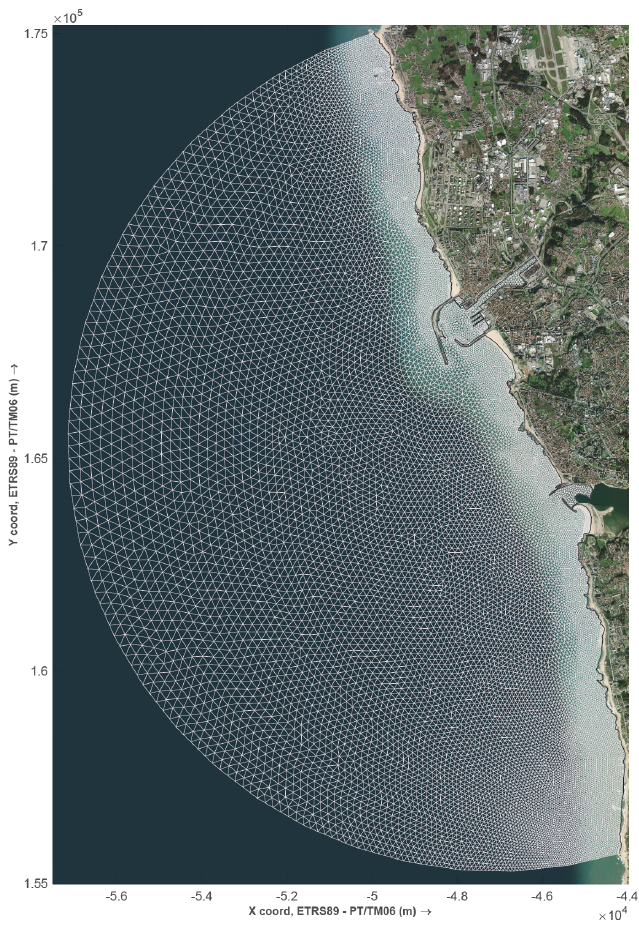
Figure A1. SWAN computational